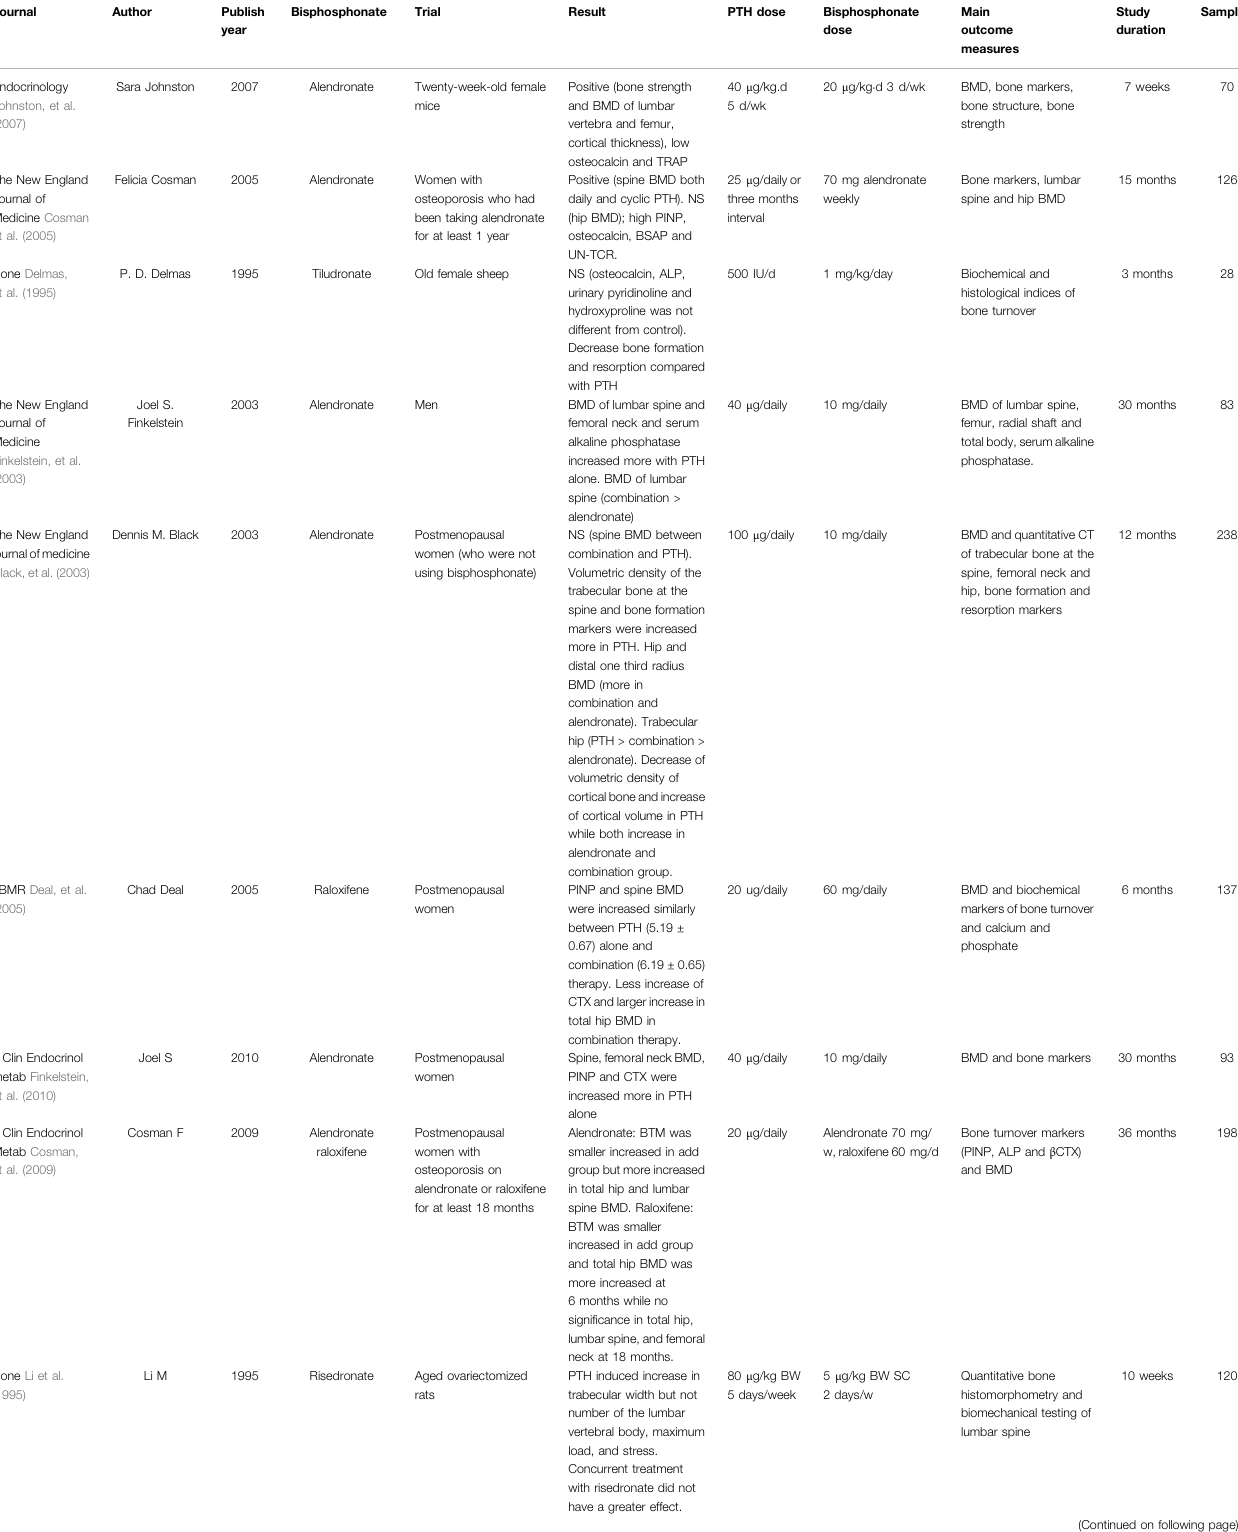
TABLE 1 | Literatures about combination PTH and antiresorptive drugs for